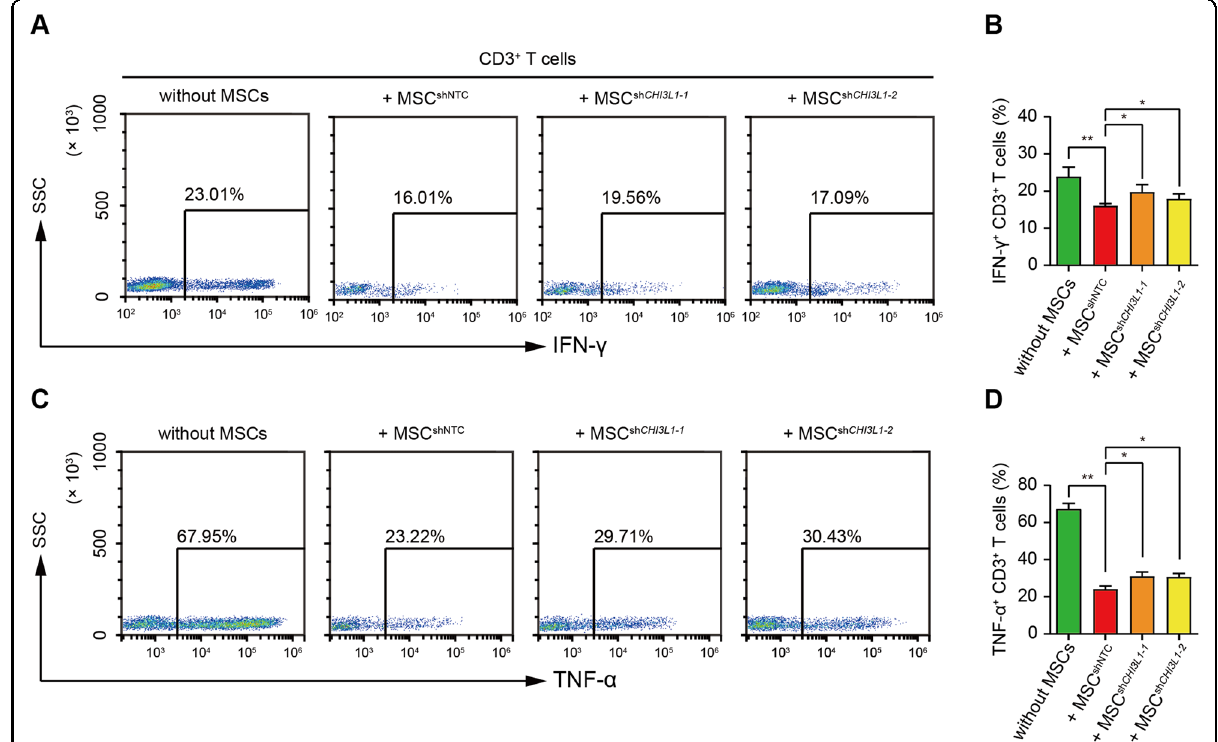
Fig. 2 hUC-MSCs downregulate the pro-in fl ammatory cytokine production of CD3 + T cells partially through CHI3L1 in vitro. A Representative plots and quanti fi cation ( B ) of fl ow cytometry analysis for IFN- γ -producing CD3 + T cells in indicated groups. C Representative plots and quanti fi cation ( D ) of fl ow cytometry analysis for TNF- α -producing CD3 + T cells in indicated groups. Flow cytometry analysis were conducted 3 days after CD3 + T cells co-cultured with MSCs. Data in ( B ) and ( D ) are shown as mean ± SD ( n = 3 biological replicates) with the indicated signi fi cance (* p < 0.05, ** p <